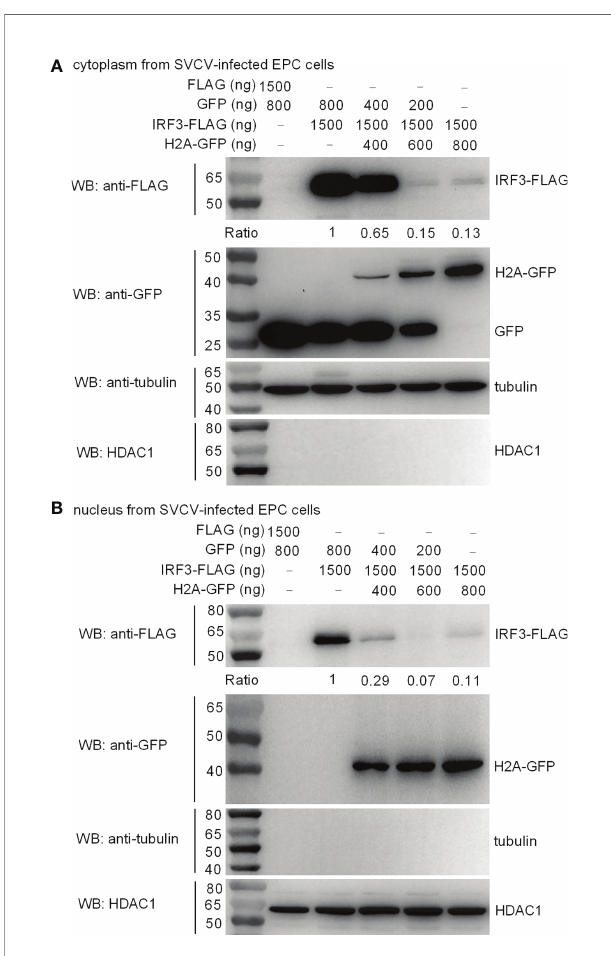
FIGURE 6 | Zebra fi sh histone H2A impairs the protein expression of cytoplasmic (A) and nuclear IRF3 protein (B) . For (A, B) , EPC cells seeded in 6-well plates were transfected with various indicated plasmids. After 36 h post-transfection, the cells were infected with SVCV. After 12 h, the cells were harvested and used for preparation of nuclear and cytoplasmic extracts. The expression ratio for IRF3 protein was quanti fi ed by Quantity